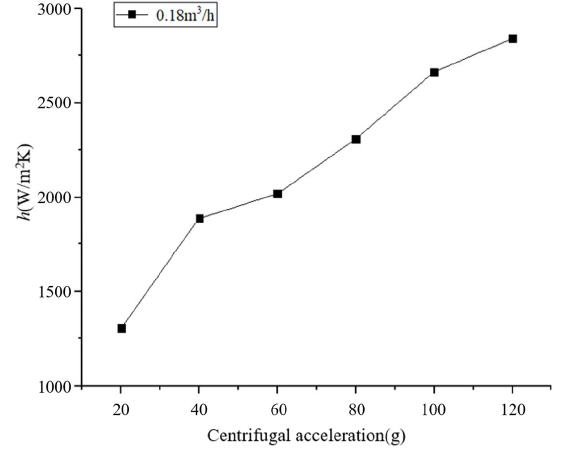
Figure 14. The convective transfer coefficient vs. the centrifugal acceleration.